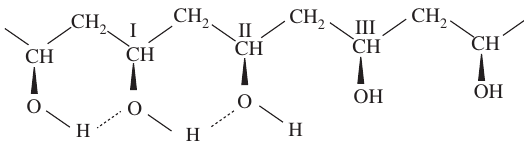
Figure 5: Schematic diagram of the intramolecular hydrogen bonding in the triad sequences of